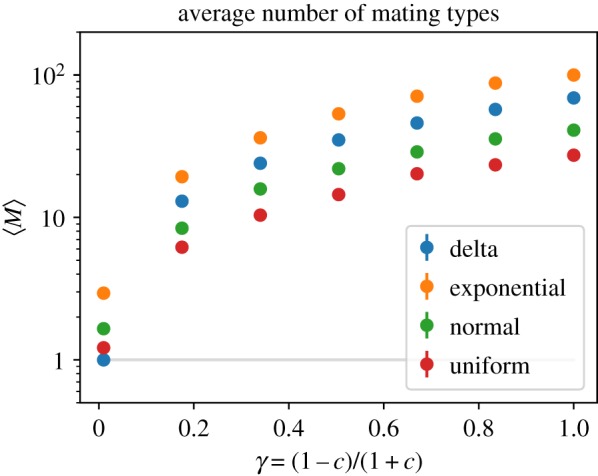
Average number of mating types against the model parameter γ = (1 − c)/(1 + c) for mutant mortality rates drawn from different distributions; (i) Dirac-delta distribution with peak at r¯=0.02, (ii) exponential distribution with scale parameter β = 0.01 and left-shift rb = −0.01, (iii) normal distribution with mean E[r]=0.001 and variance Var[r] = 0.001, (iv) uniform distribution with mean E[r]=0 and variance Var[r] = 0.002.